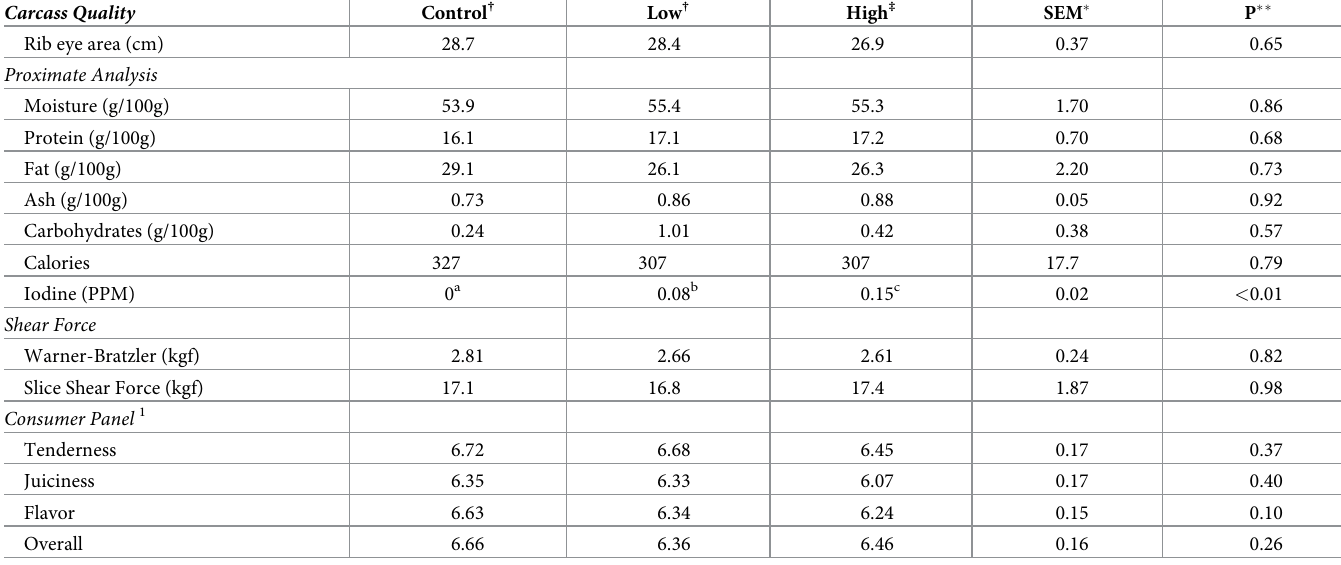
Table 6. Effect of Asparagopsis taxiformis inclusion at 0.25% (Low) and 0.5% (High) on carcass quality, proximate analysis, shear force, and consumer panel preference. Carcass